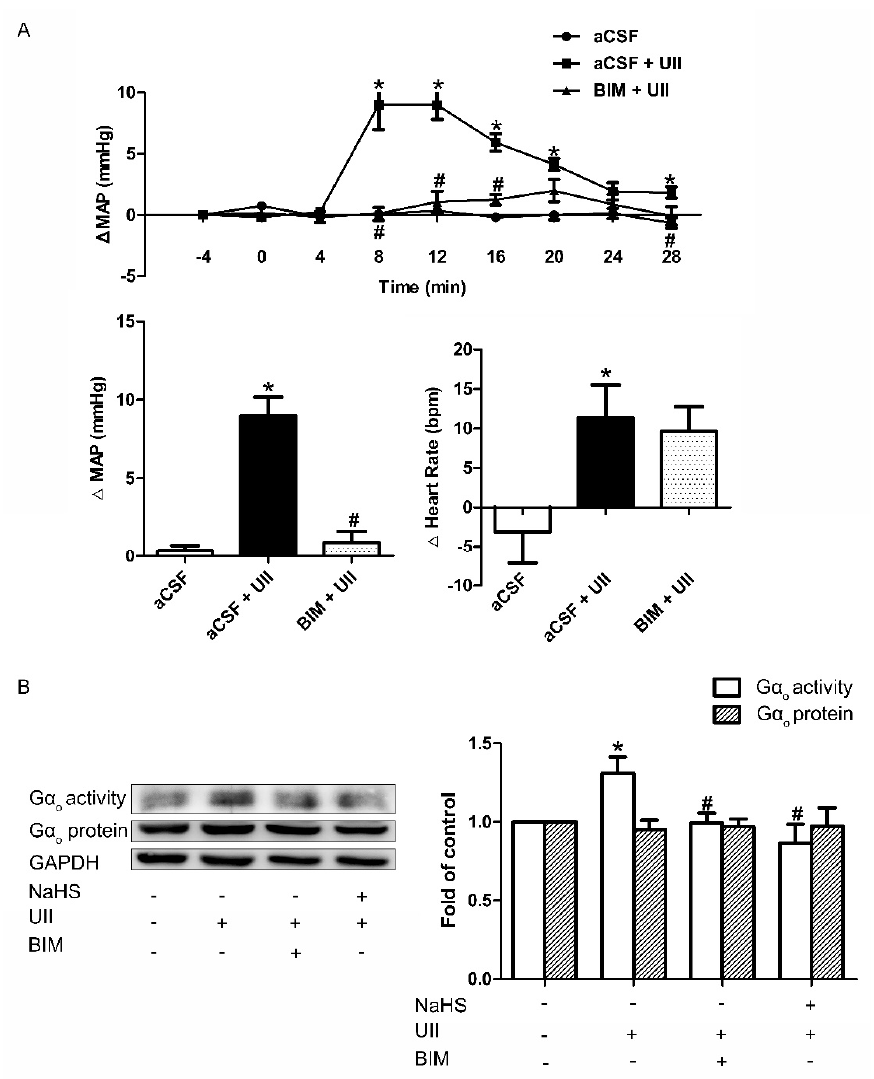
Figure 10. Inhibitory role of NaHS on UII − induced G α o activation. Time course of MAP and the maximal changes in MAP and HR in response to microinjection of aCSF, aCSF + UII, or BIM + UII into the RVLM of SD rats ( A ). The change in the activity and protein level of G α o after pretreatment with NaHS or BIM for 30 min before UII was used ( B ). Densitometric analysis of the viability of G α o ( B ). Mean ± SEM. n = 6. * p < 0.05 vs. aCSF group; # p < 0.05 vs. aCSF + UII group. 4. Discussion It is well established that UII participates in central cardiovascular control through the activation of UT. H 2 S elicits an antihypertensive effect through reduced ROS produc- tion. In the present study, we provide the first evidence demonstrating that H 2 S may exert an inhibitory role in UII-induced cardiovascular effects via G α o -ROS-p38MAPK/ERK1/2 pathway. Our statement is supported by the following four findings: (1) The metabolic system of H 2 S was present in the RVLM of SD rat and SH-SY5Y cells. Pretreatment with microinjection of H 2 S into the RVLM significantly attenuated UII-induced MAP and HR rise. (2) H 2 S decreased the UII-induced MAP and HR by inhibiting the activity of NADPH oxidase, phosphorylation of its subunit, p47 phox , and ROS production. (3) Decreased phos- phorylation of p38MAPK and ERK1/2 plays an active role in the inhibitory role of H 2 S on UII-induced cardiovascular effects, and p38MAPK/ERK1/2 pathway is in the downstream